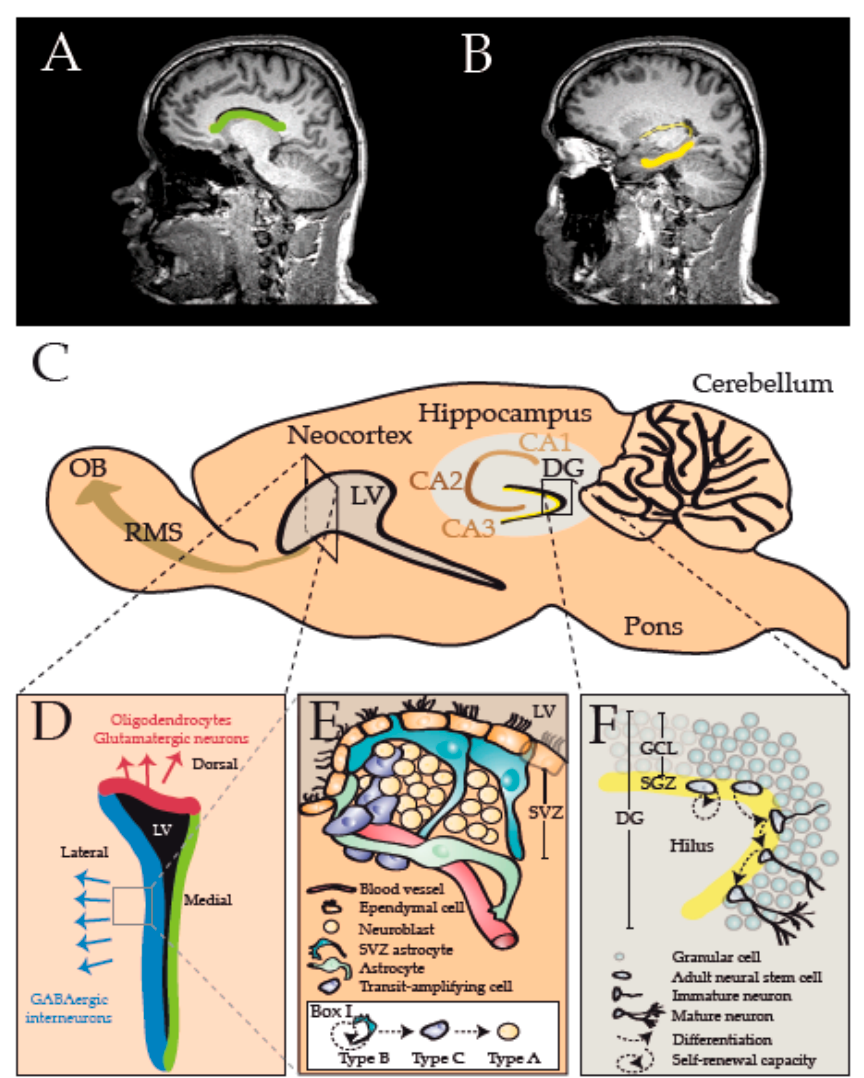
Figure 1. The mammalian central nervous system (CNS) comprises two major stem cell niches: the subventricular zone (SVZ) lining the lateral ventricles (LV), and the subgranular zone (SGZ) in the dentate gyrus (DG) of the hippocampus, as depicted in the human brain (green and yellow areas on magnetic resonance images (MRI) in ( A ) and ( B ), respectively) and rodent brain ( C ); ( D ) The SVZ (coronal view) can be divided into different microdomains based on the progenies of neural stem cells (NSCs): whereas the dorsal domain (red) produces predominantly oligodendrocytes (OLs) and glutamatergic neurons, the lateral domain (blue) generates mainly GABAergic interneurons, and the medial domain is largely non-neurogenic after 2.5 months of life; ( E ) A detailed view of the lateral SVZ shows the microarchitecture of this niche, including self-renewing NSCs (Type B/SVZ astrocyte) that can give rise to transit-amplifying cells (Type C cells). These multipotent progenitors can produce neuroblasts (Type A cells) as well as glial cells, including OLs (Box I). Newly formed neuroblasts usually migrate along the rostral-migratory stream (RMS) to the olfactory bulb (OB), whereas cells determined to become OLs usually migrate into nearby white matter tracts; ( F ) A close-up view of the SGZ depicts how NSCs (Adult neural stem cells) within the hilus of the DG can self-renew or give rise to neurons that are incorporated into the granular cell layer (GCL). In addition to neuronal cells, NSCs within the SGZ also have the potential generate OLs.